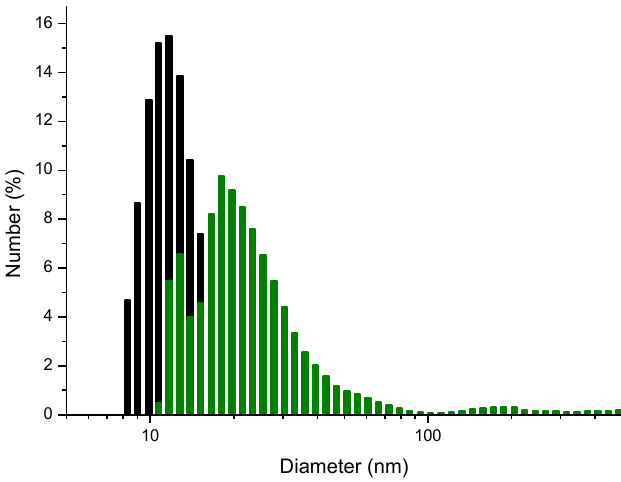
Figure 8. Particle size distribution histograms of the ZnS:Mn-Asp NCs only (black, 19.8 nm in average), and the ZnS:Mn-Asp-Cu adduct (green, 58.4 nm in average) in aqueous solution.